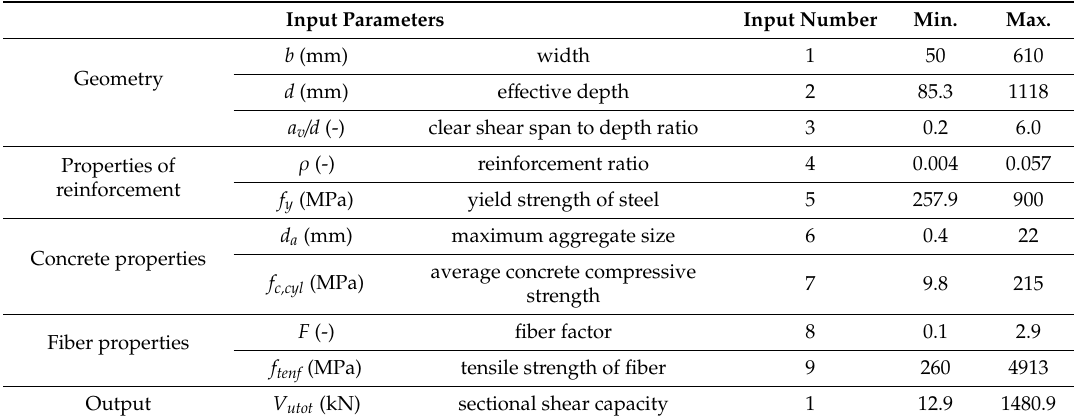
Table 2. Overview of input and output variables considered in the dataset, including ranges of values.